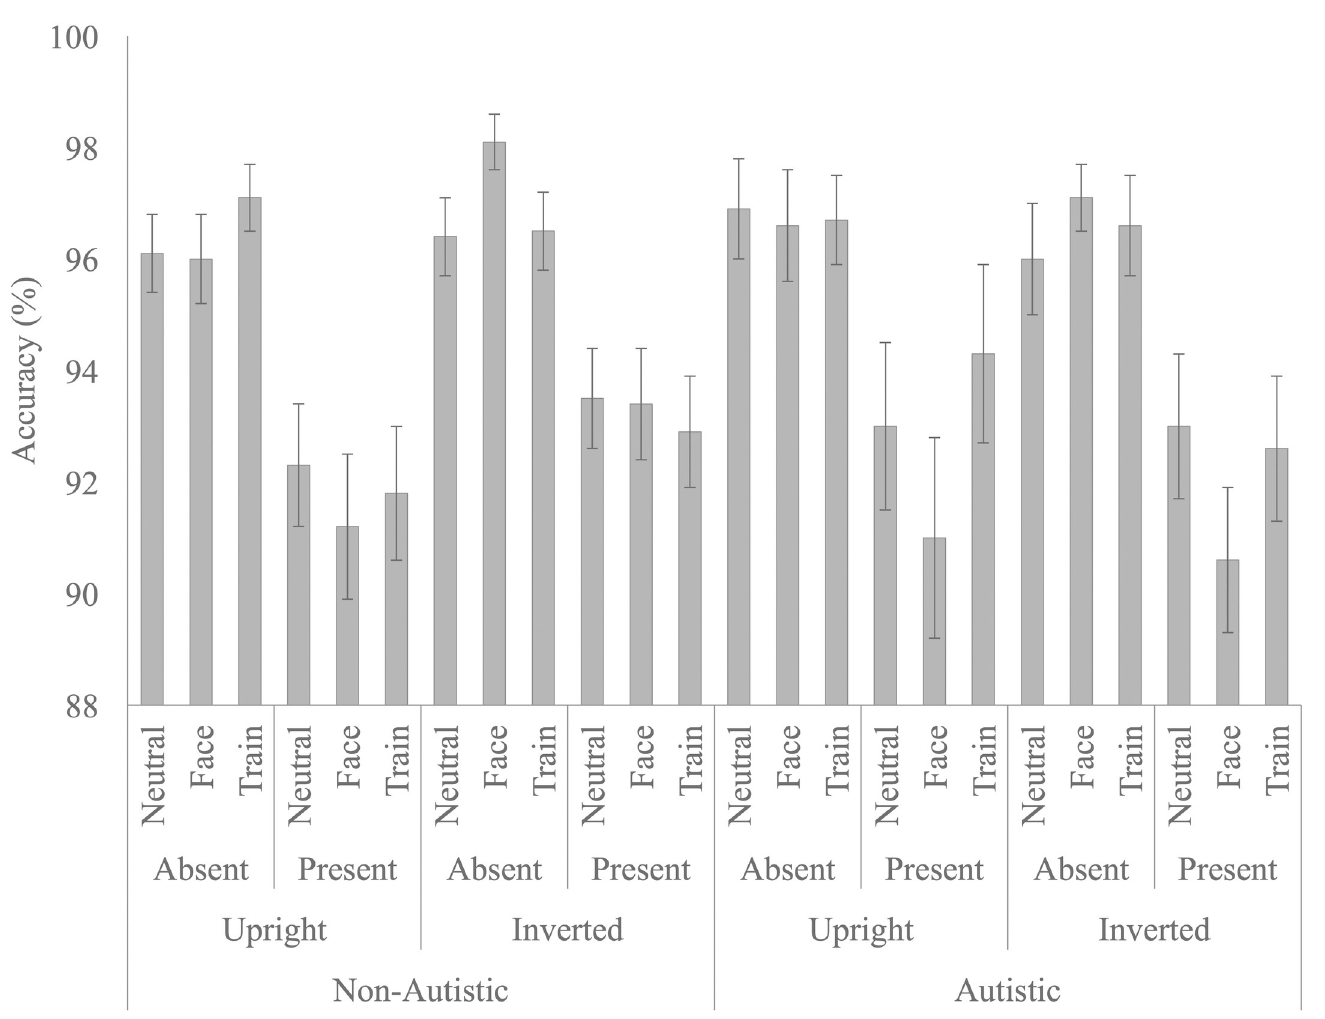
Fig 2. Accuracy (mean and standard error) as a function of diagnostic group (autistic, non-autistic), orientation (upright, inverted), target status (present, absent), and distractor (neutral, train, face).